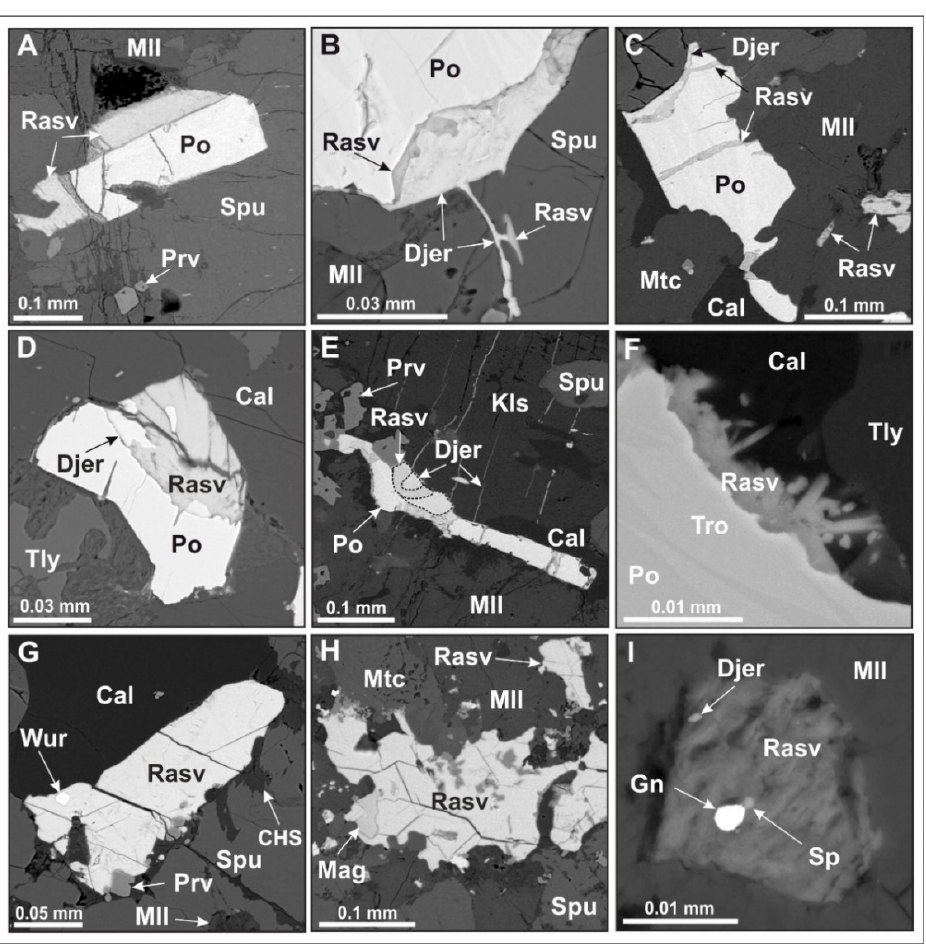
Figure 12. Rasvumite and djerfisherite from the Kochumdek marbles (backscattered electron (BSE) images). ( A ) Pyrrhotite grain overgrown by rasvumite. This kind of pyrrhotite-rasvumite boundary is usually even in shape and free from dissolution features. ( B–E ) Typical double-layered rims, where rasvumite and djerfisherite compose the inner (adjacent to pyrrhotite) and outer boundaries, correspondingly. Crack-filling djerfisherite in pyrrhotite ( C ), spurrite ( B ) and kalsilite ( E ). ( F ) Rasvumite microcrystals in the crack at the contact between replacement rim around pyrrhotite, calcite and tilleyite. ( G , H ) Large rasvumite grains with perfect cleavage (60 or 120 ° angles between cleavage directions) and inclusions of wurtzite, perovskite and magnetite. ( I ) Pyrrhotite pseudo-inclusion in melilite completely replaced by aggregates of needle-like rasvumite-II; blebs of galena and sphalerite are preserved as micro-inclusion in rasvumite matrix. Marbles: A, G, H, I (Zone 2), B, C (Zone 3), D-F (Zone 4). Samples: A, I = PT-102, B = PT-97, C = PT-94, D = PT-88, E = PT-89, F = PK-16-3, G = PT-107, H = PT-93. Cal = calcite, CHS = Ca-hydro-silicates, Djer = djerfisherite, Gn = galena, Kls = kalsilite, Mag = magnetite, Mll = melilite, Mtc = monticellite, Mw = merwinite, Po = pyrrhotite, Prv = perovskite, Rasv = rasvumite, Rnk = rankinite, Sp = sphalerite, Spu = spurrite, Tly = tilleyite, Tro = troilite, Wur = wurtzite.